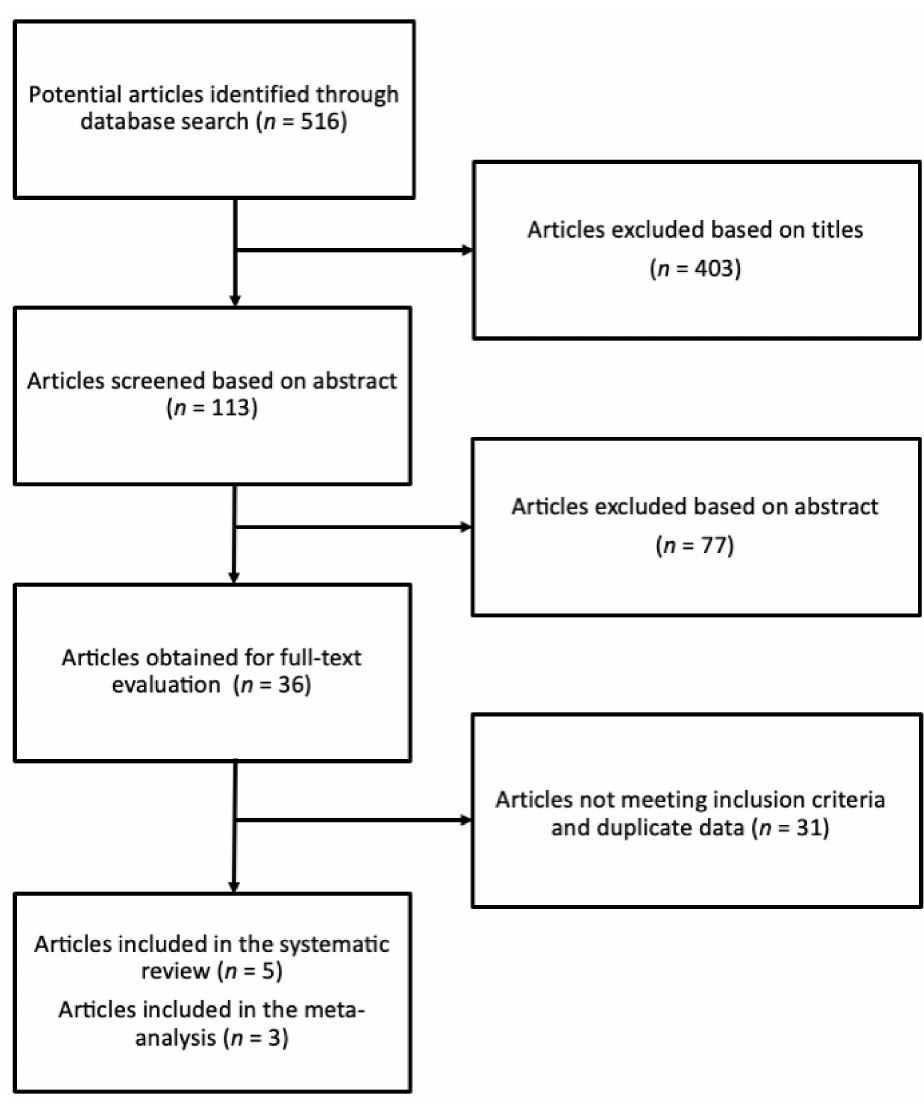
Figure 1. Study selection